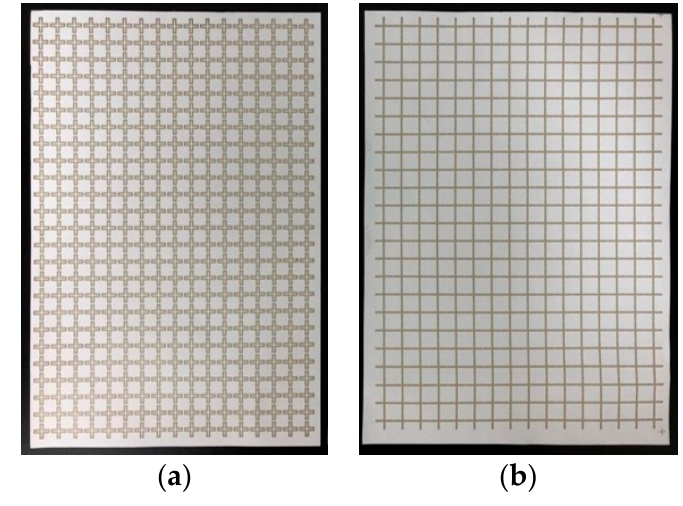
Figure 4. Fabrication FSS on paper: ( a ) Loop type; ( b ) Patch type.